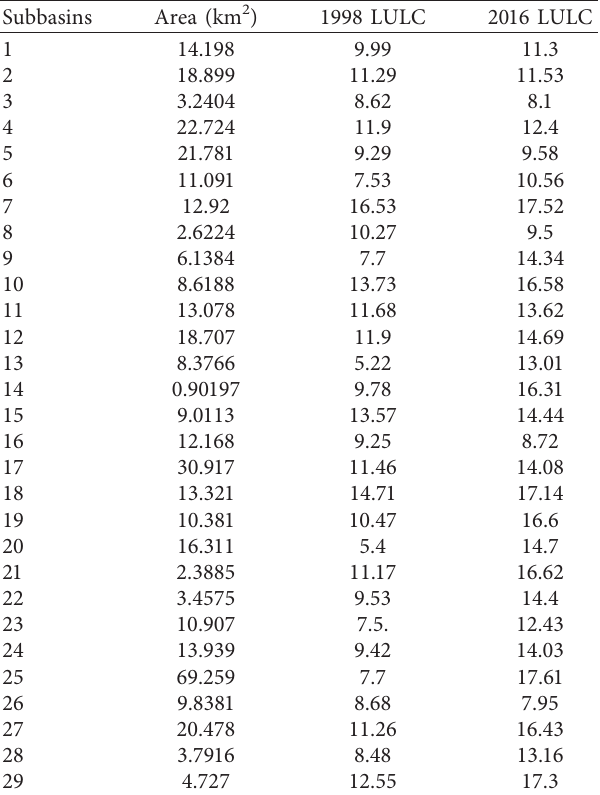
Table 18: Summary of simulated mean annual sediment yield (t/ha/year) comparison at the subbasin level.